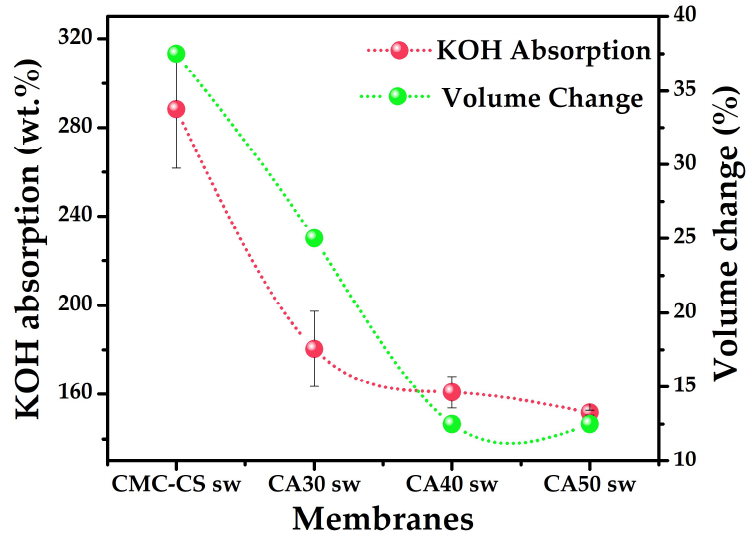
Figure 2. Swelling behavior in mass percentage and volume change of the CMC-CS sw hydrogels at different CA proportions.